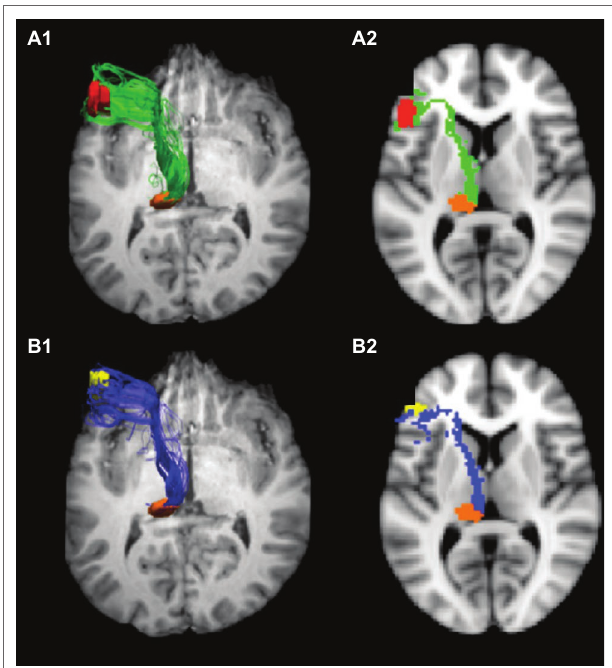
FIGURE 2 | Tracts from Broca’s area to pulvinar. Connections from Broca’s area enter the internal medullary lamina between the anterior and ventral anterior nuclei, where some fibers enter the ventral anterior nucleus and others course via the internal medullary lamina to the pulvinar. These images show the tracts from pars opercularis (A1,A2) and pars triangularis (B1,B2) to the pulvinar. The images on the left (A1,B1) represent 3-D views of the tracts overlaid on an axial image ventral to the tracts, and the images on the right are 2-D rendering of the tracts through a single slice ( Z = 38). Adapted from Bohsali et al. (2015). Copyright 2015 with permission from